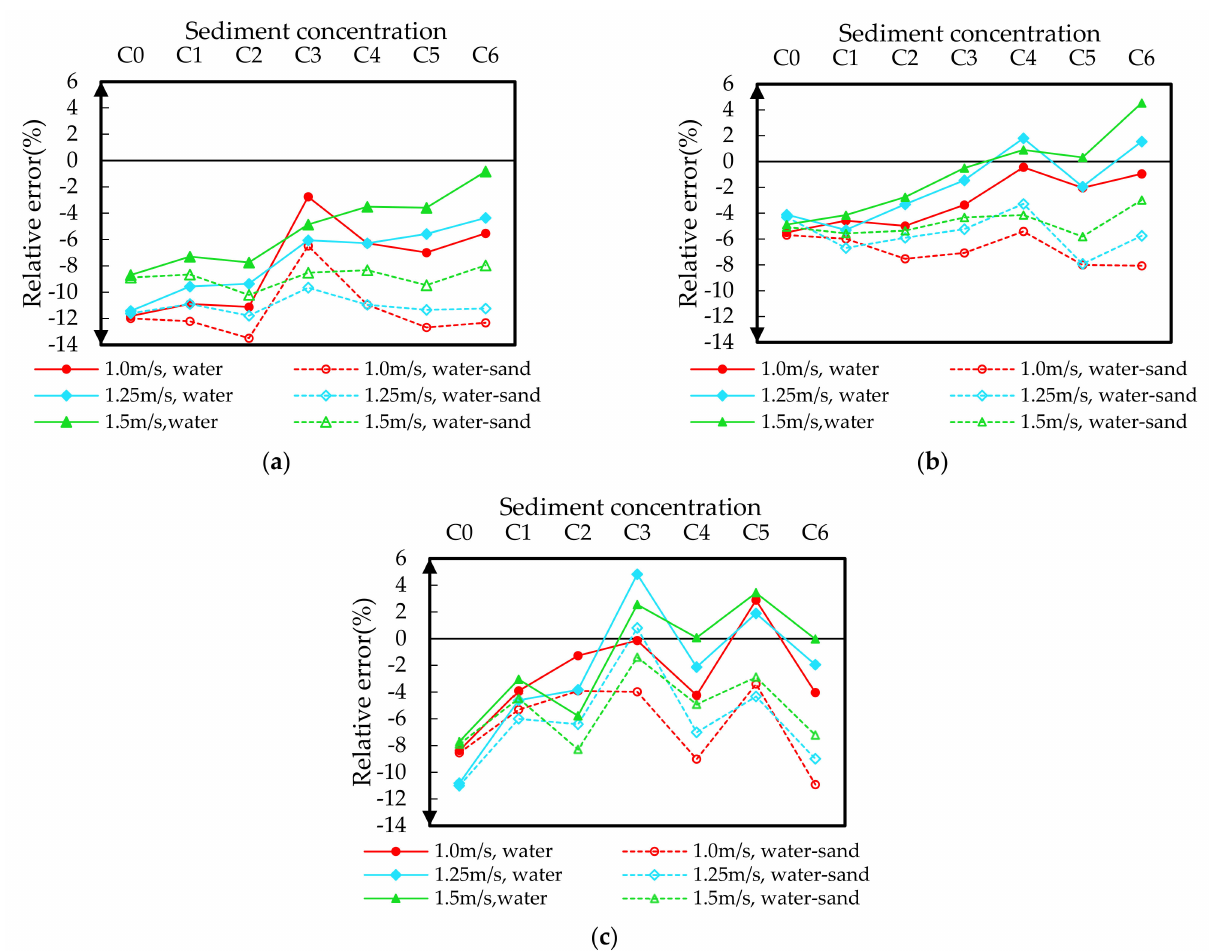
Figure 5. The relative error of the measured flow values between each metering device and the right triangle weir. ( a ) The relative error between electromagnetic flowmeter and the right triangle weir; ( b ) the relative error between ultrasonic flowmeter and the right triangle weir; ( c ) the relative error between water meter and the right triangle